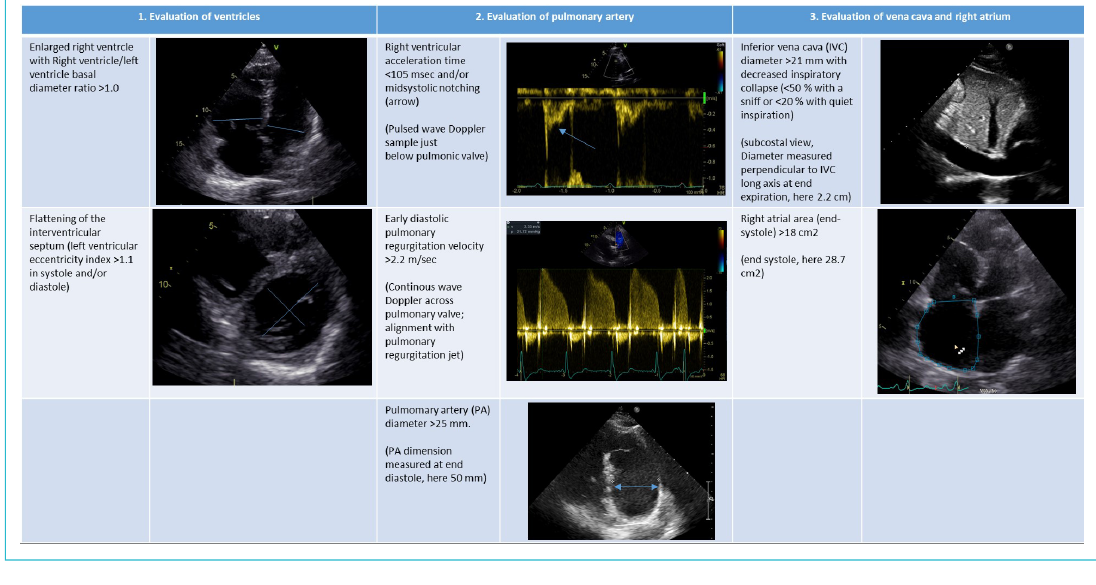
Figure 2: Indirect signs of pulmonary hypertension at the levels of the ventricles, pulmonary valve / pulmonary artery and inferior vena cava / right atrium. Adapted from Galiè 2016 [1].